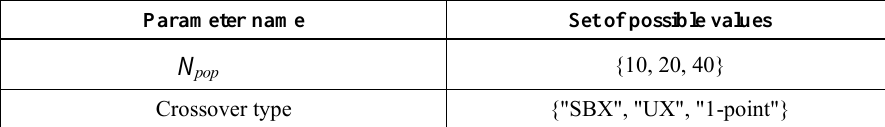
Table 1. Possible values of the parameters of NSGA